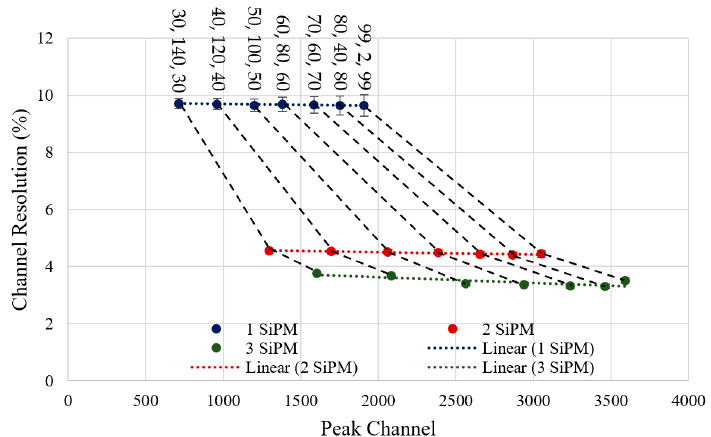
Figure 14. Graph of channel resolution from each detected peak across all LED testing experiments, with three-sigma error bars. Three lines of best fi t consisting of coloured do tt ed lines have been added on each set of resolution values for 1, 2, and 3 SiPMs, respectively.